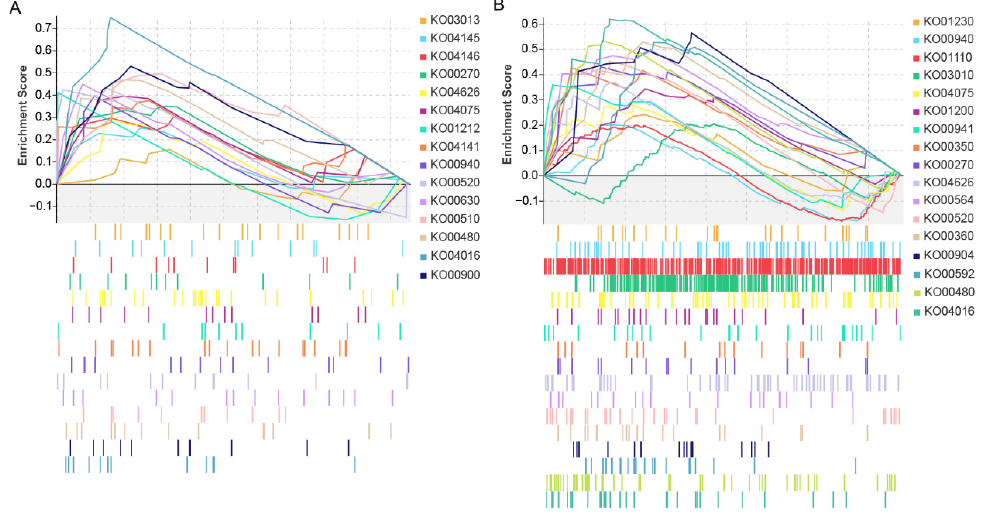
Figure 5. GSEA of genes in the addition line II-9-3: ( A ) GSEA of A. cristatum genes; ( B ) GSEA of wheat genes .